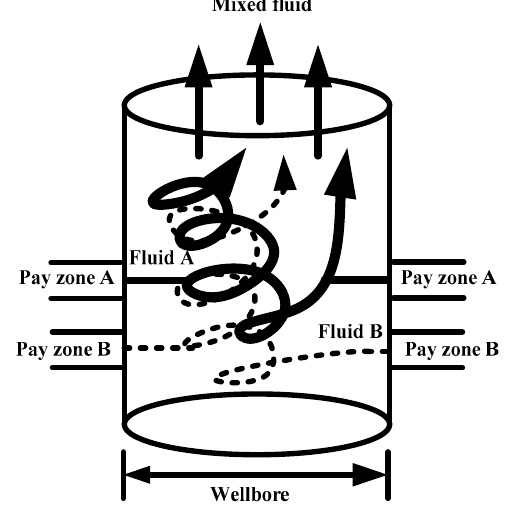
Figure 2. Schematic of two-phase fluid flow in the tubing.